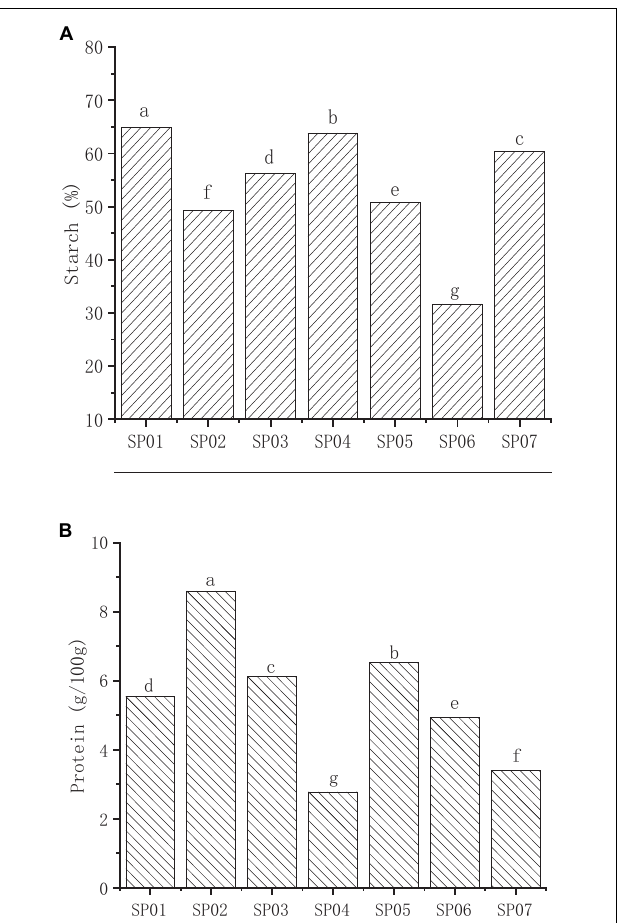
FIGURE 1 | The content of starch (A) and protein (B) in different varieties of sweet potato powder. Different letters indicate significant differences ( p <